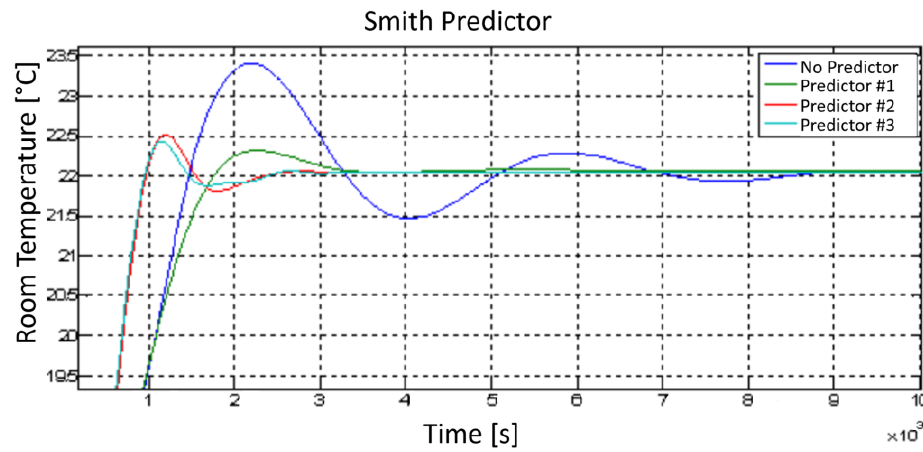
Figure 20. Control results: Smith Predictor architecture performances (CV).